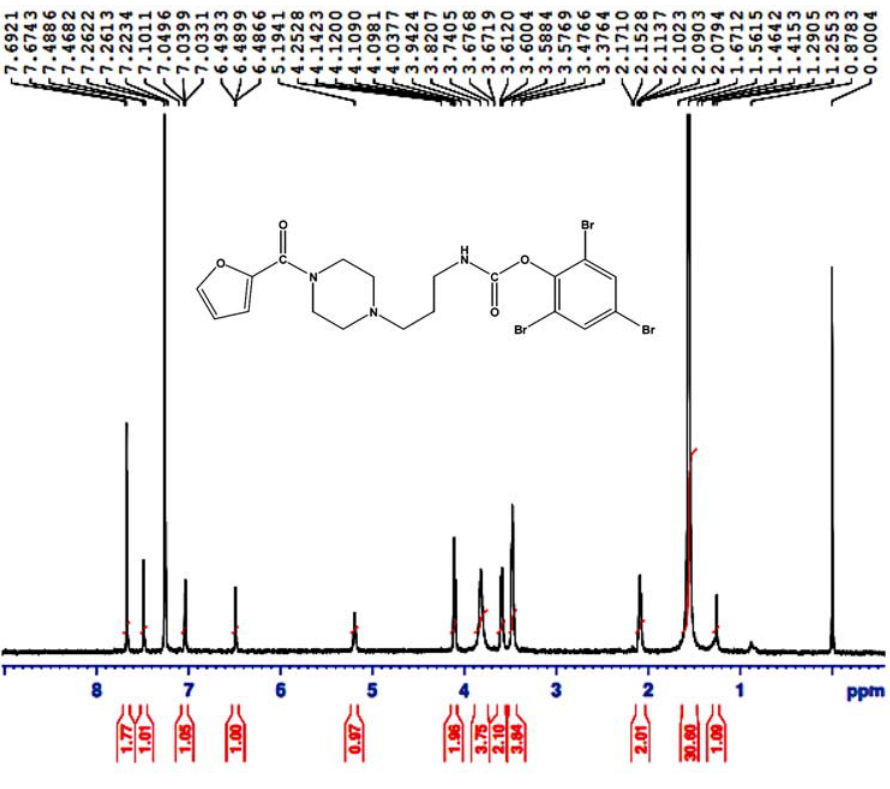
Fig. 3. 1 H-NMR spectrum of 2,4,6-tribromophenyl-3- [ 4-(2-furoyl)-1-piperazinyl ] propylcarbamate ( 16 )